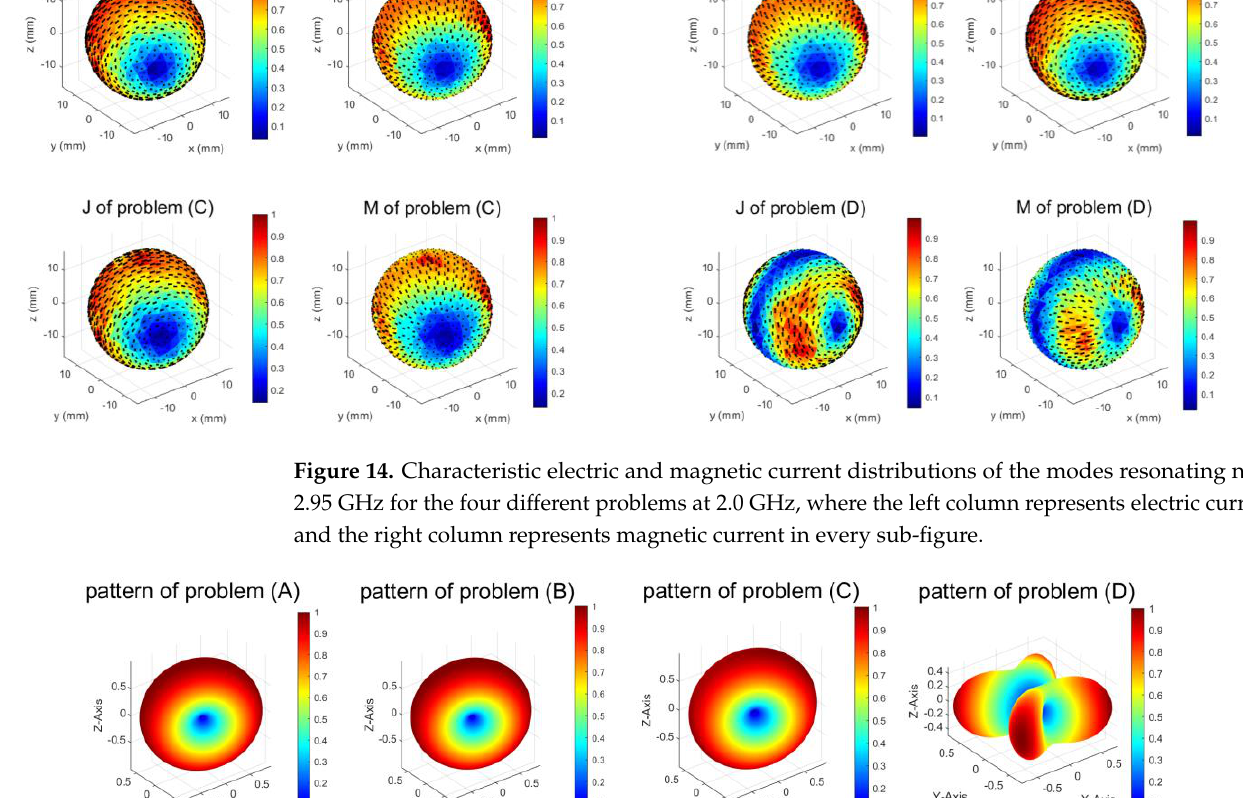
Figure 16. Characteristic current distributions and normalized pattern of mode 3 resonating near 4.3 GHz for problem (C) at 2.0 GHz, where the left column represents electric current, the middle column represents magnetic current, and the right column represents normalized pattern.